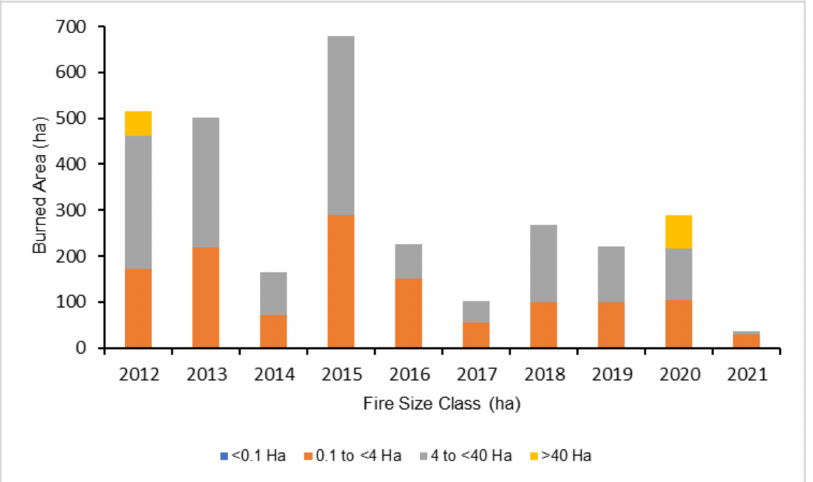
Figure 5. Wildfire burned area (ha) per year from 2012 to 2021 on Babeldaob Island, Palau, by National Wildfire Coordinating Group size classes. Table 5. Number and percentage of wildfires, area burned (ha), and percentage of area burned